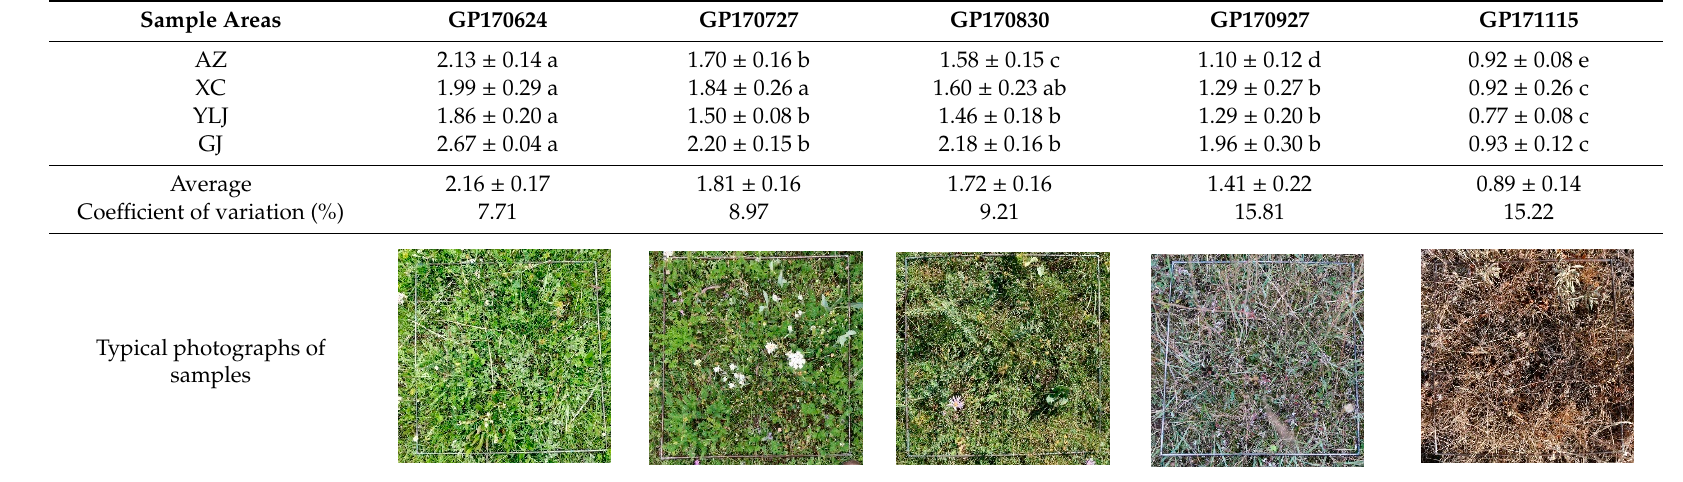
Table 2. Variations in forage N contents (%) during different growth periods at the four sites. In the same sample area and growth period, the N content is the average of the corresponding five sample plots.